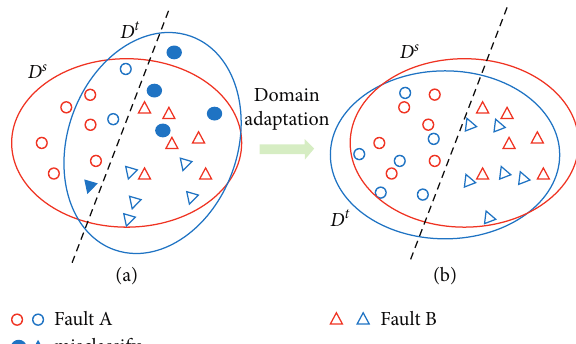
Figure 1: Illustration for domain adaptation: (a) without domain adaptation and (b) with domain